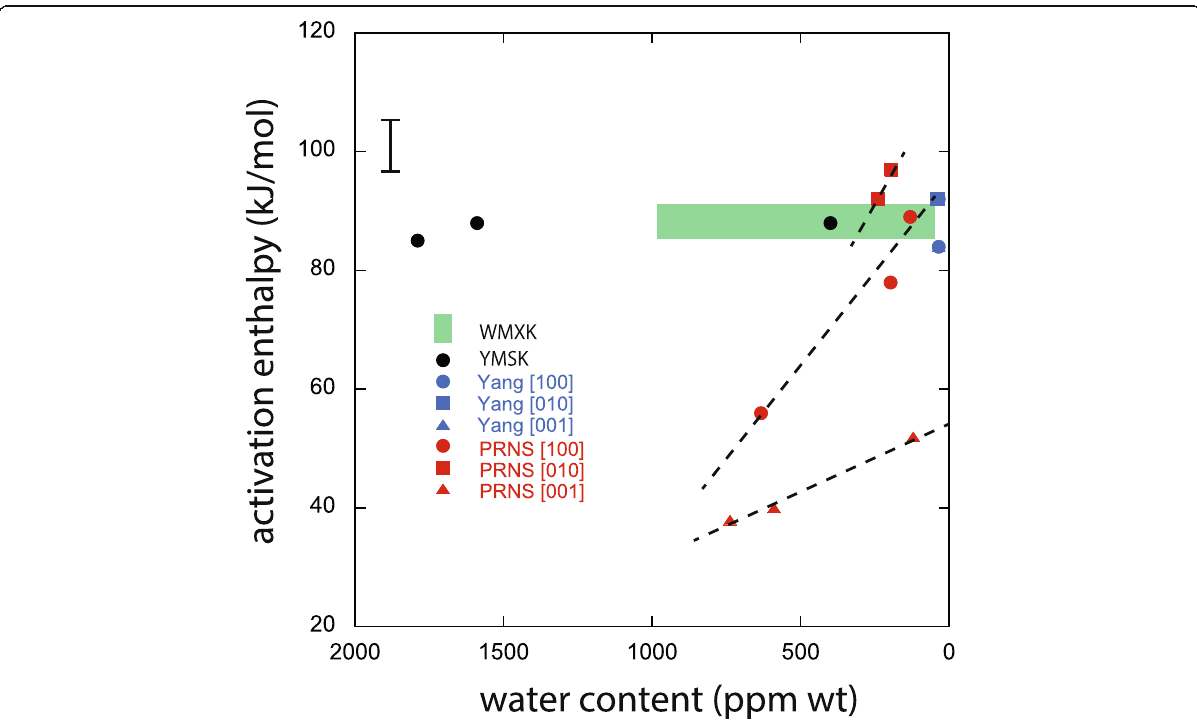
Fig. 9 Relation between the activation enthalpy and water content in olivine. The data are from Wang et al. (2006), Yoshino et al. (2009), and Poe et al. (2010). No clear trend can be seen except for the results from Poe et al. (2010). The water content dependence of activation enthalpy is also very small for wadsleyite (e.g., Dai and Karato 2009b; Yoshino et al.